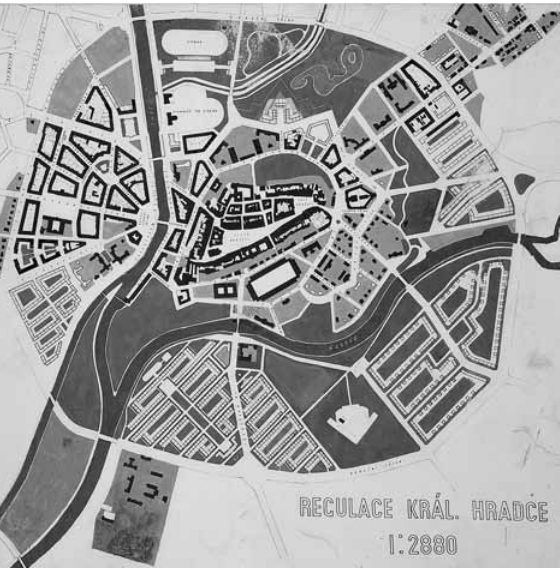
fig. 7. j. Gočár, urban project for the city of Hradec